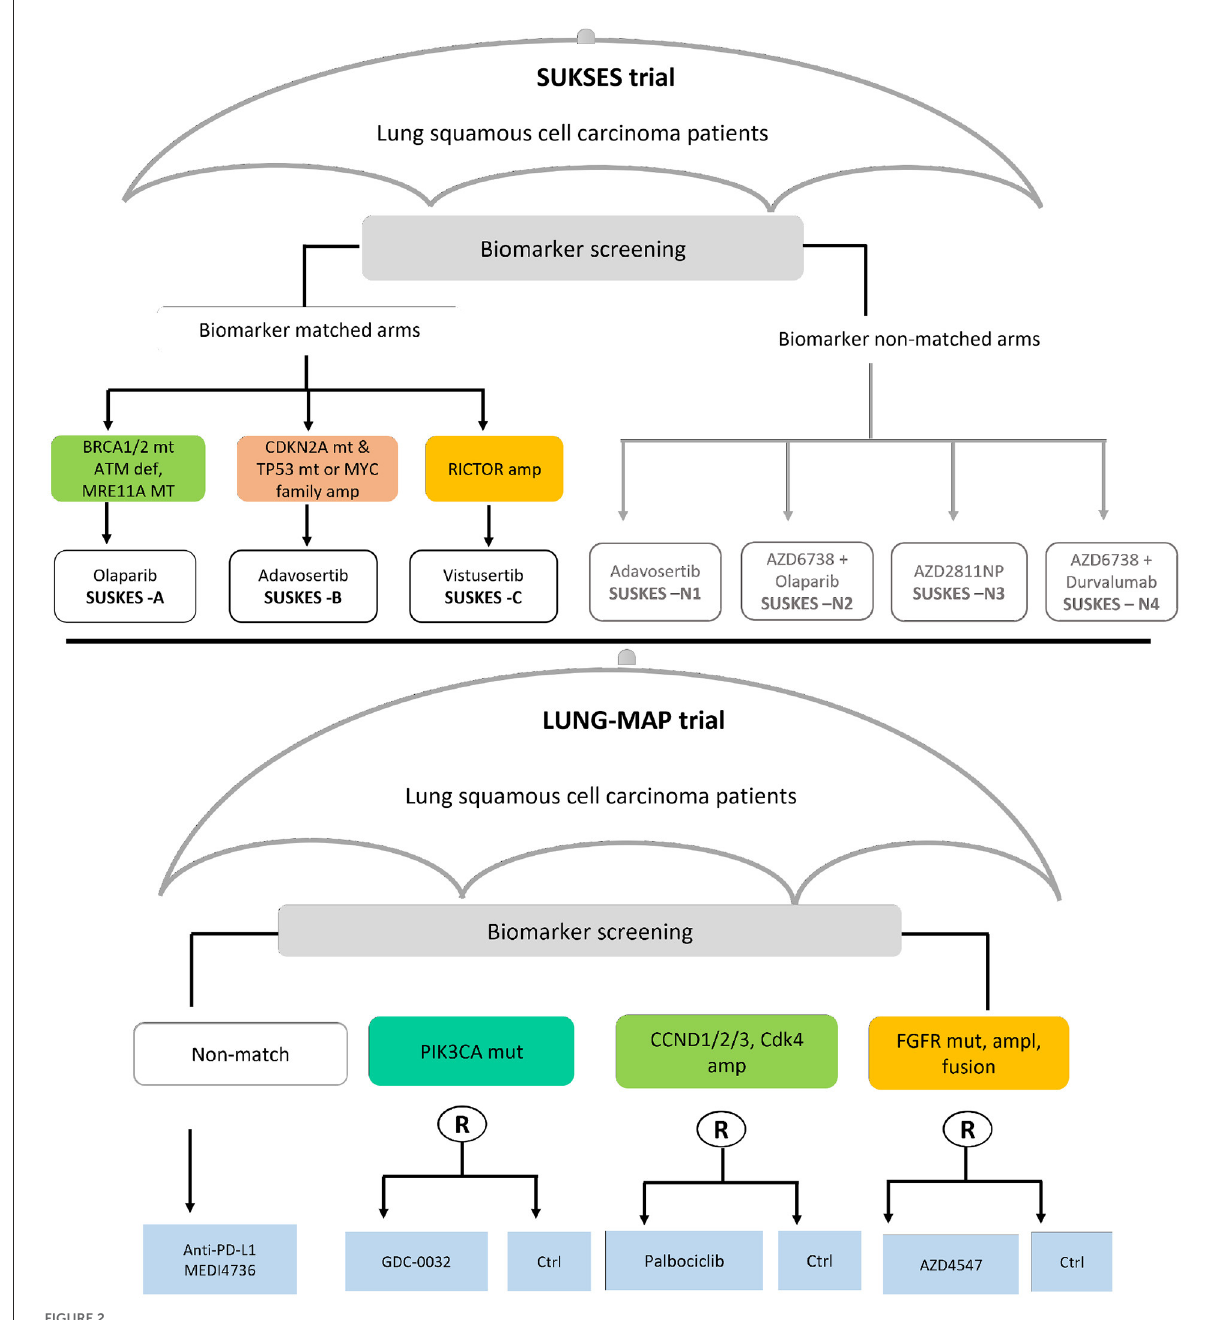
FIGURE2 Two examples of real umbrella trials featuring distinct designs. The schema in the top panel depicts the small cell lung cancer umbrella korea studies (SUKSES–NCT02688894) trial. The bottom panel demonstrates the study schema of the lung cancer master protocol (Lung-MAP–NCT03851445)